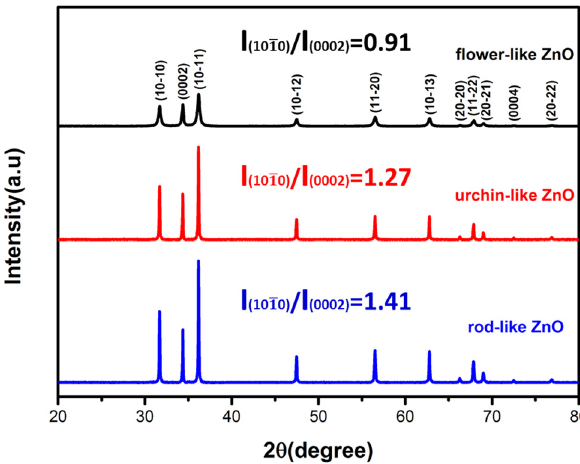
Figure 3: XRD patterns of the three samples.